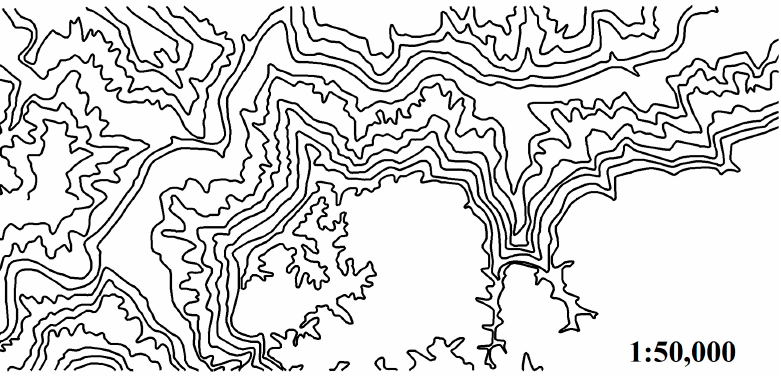
Figure 8. Contour line dataset with a scale of 1:50,000 in the northeastern part of Huimin, Chongqing, China.